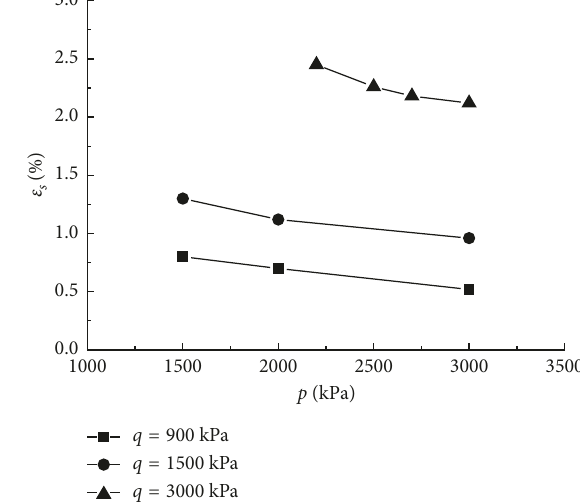
Figure 6: p versus ε s curve (stress conditions of equal q and unequal p ).